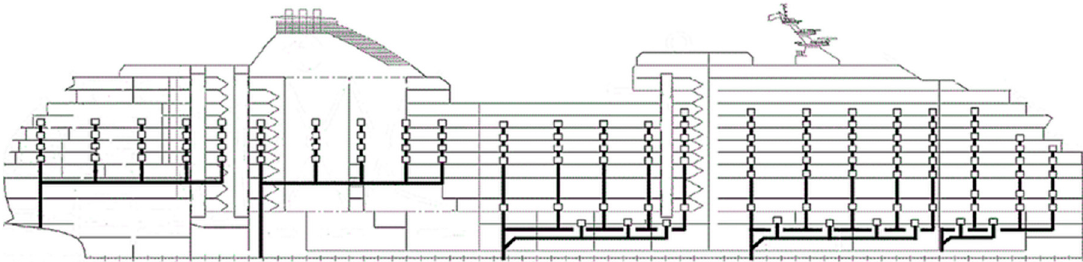
Figure 3. Grey water distribution system on cruise ship (example). Source: authors .